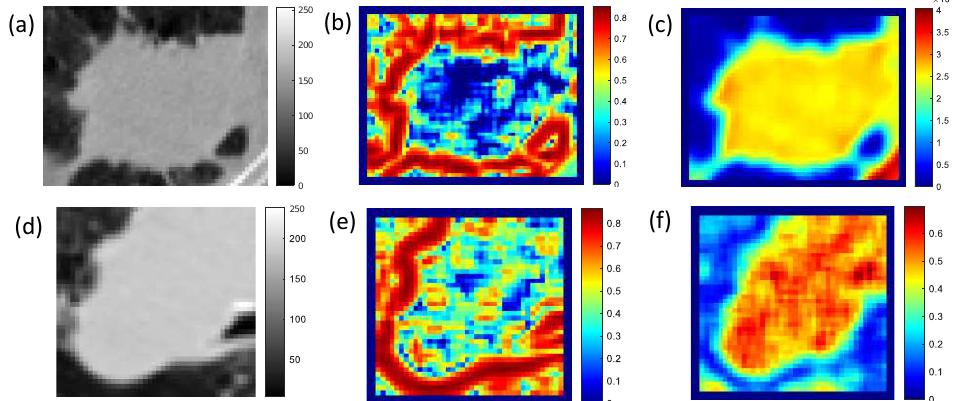
Figure 9. Top-ranked radiomic descriptors identified based on pathomic-radiomic associations and evaluated in Experiment 3, visualized as a heatmap (where red corresponds to over-expression): ( a , d ) Tumor on CT image, ( b , e ) Haralick correlation, ( c , f ) Haralick homogeneity for a representative ADC study (top row) as well as a representative SCC study (bottom